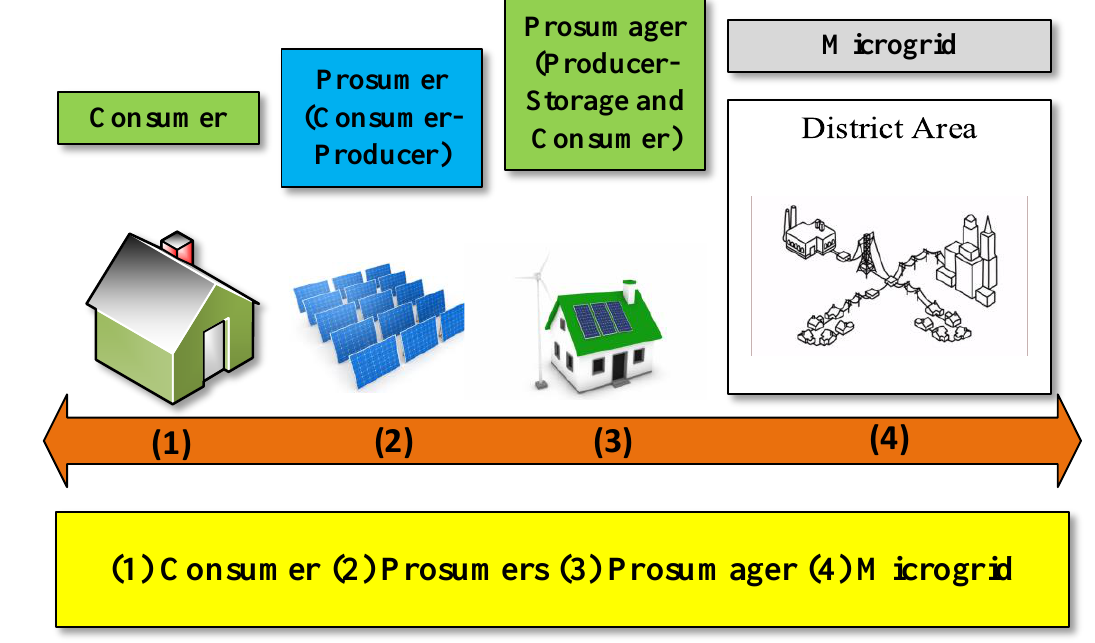
Figure 4. Comparison of Consumer vs. Prosumer vs. Prosumager vs. Microgrid. It means the consumer takes power from the microgrid, the prosumer acts as a producer and consumer, whereas the prosumager acts as power producer, consumer, and stores the energy for future purposes. A simple comparison among microgrids is shown in Figure 4, describing the general comparison with a consumer, prosumer, prosumager, and district area